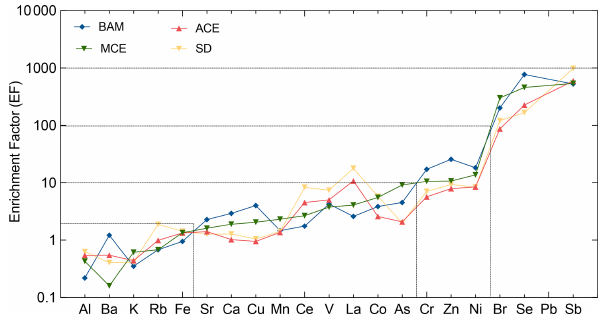
Figure 7. Crustal enrichment factors (EFs) of aerosol PM 10 eval- uated for the different trace metal elements at AMV. The averaged values are plotted according to their respective air mass